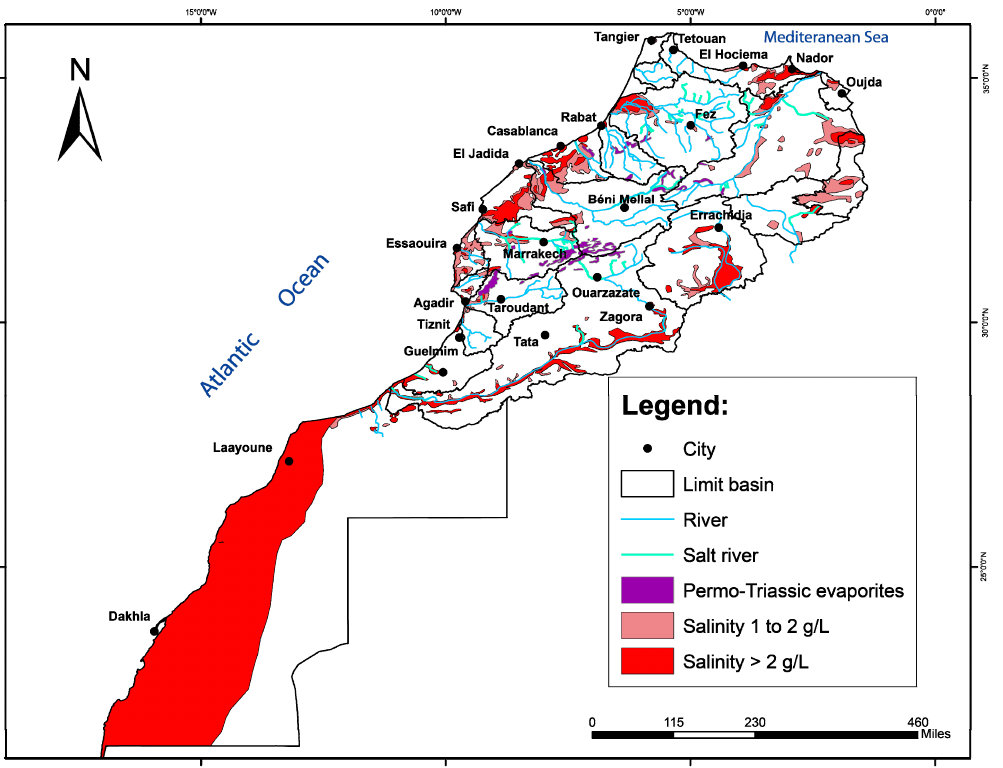
Figure 5. Spatial distribution of saline aquifers and rivers in Morocco.